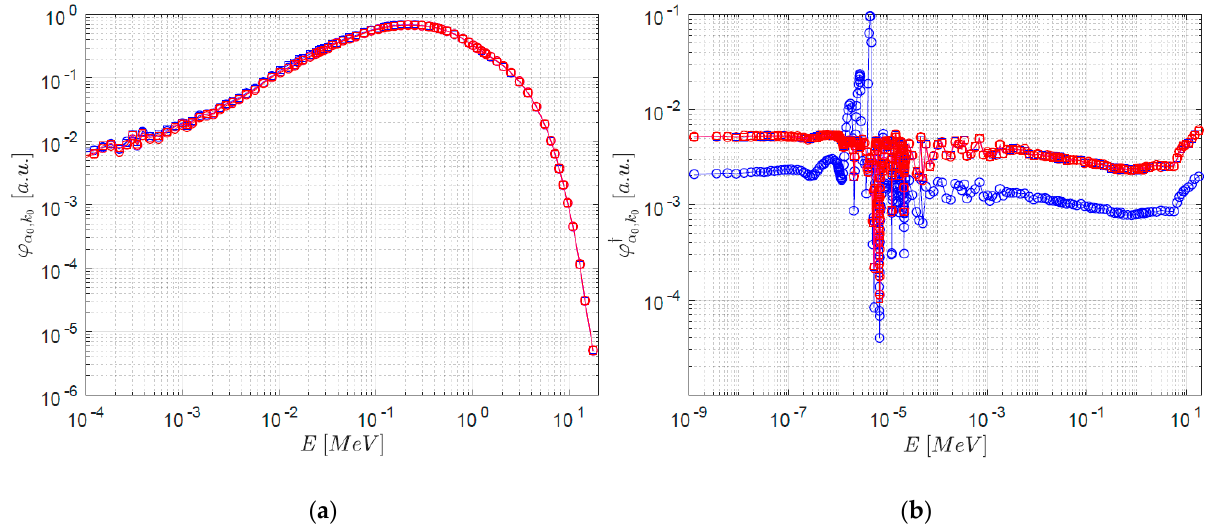
Figure 1. Problem I, sub-critical configuration, direct ( a ) and adjoint ( b ) fundamental distributions according to the α -(blue) and k -(red) eigenvalue formulations, with (squares) and without (circles) delayed contributions.